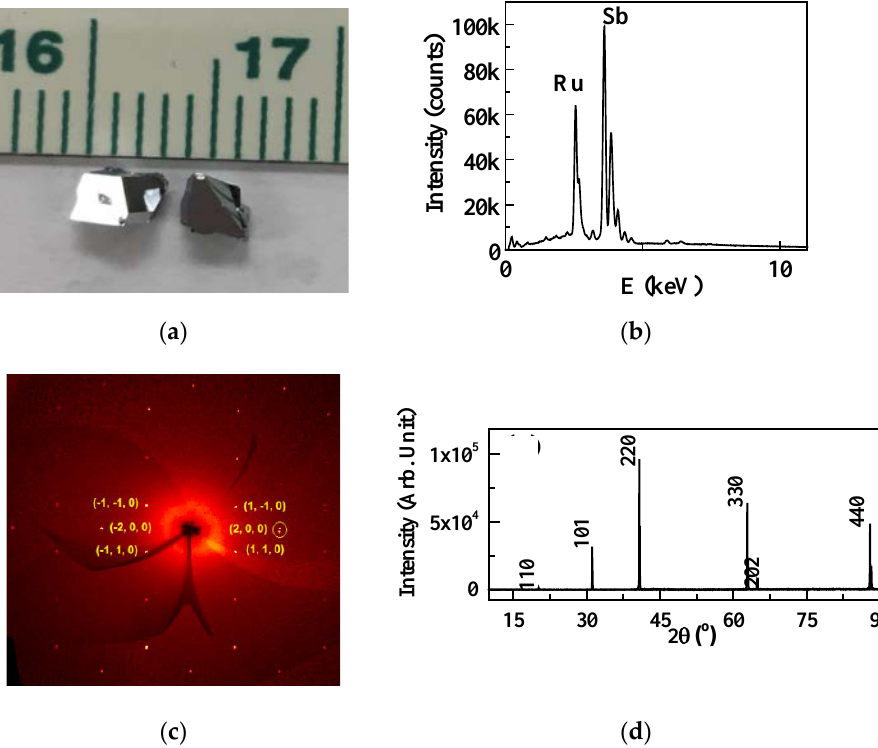
Figure 1. ( a ) Image of a single crystal; ( b ) energy dispersion X-ray (EDX) image; ( c ) XRD procession image on a single crystal, with the number as the (h k 0) index; ( d ) powder XRD patterns measured on the ac and ab planes of RuSb 2+ single crystal.